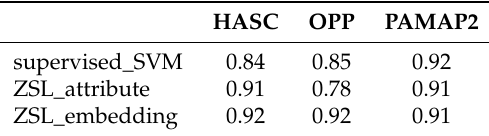
Table 6. Evaluation of the methods without unknown classes. F1-Score when using 30% as test data.